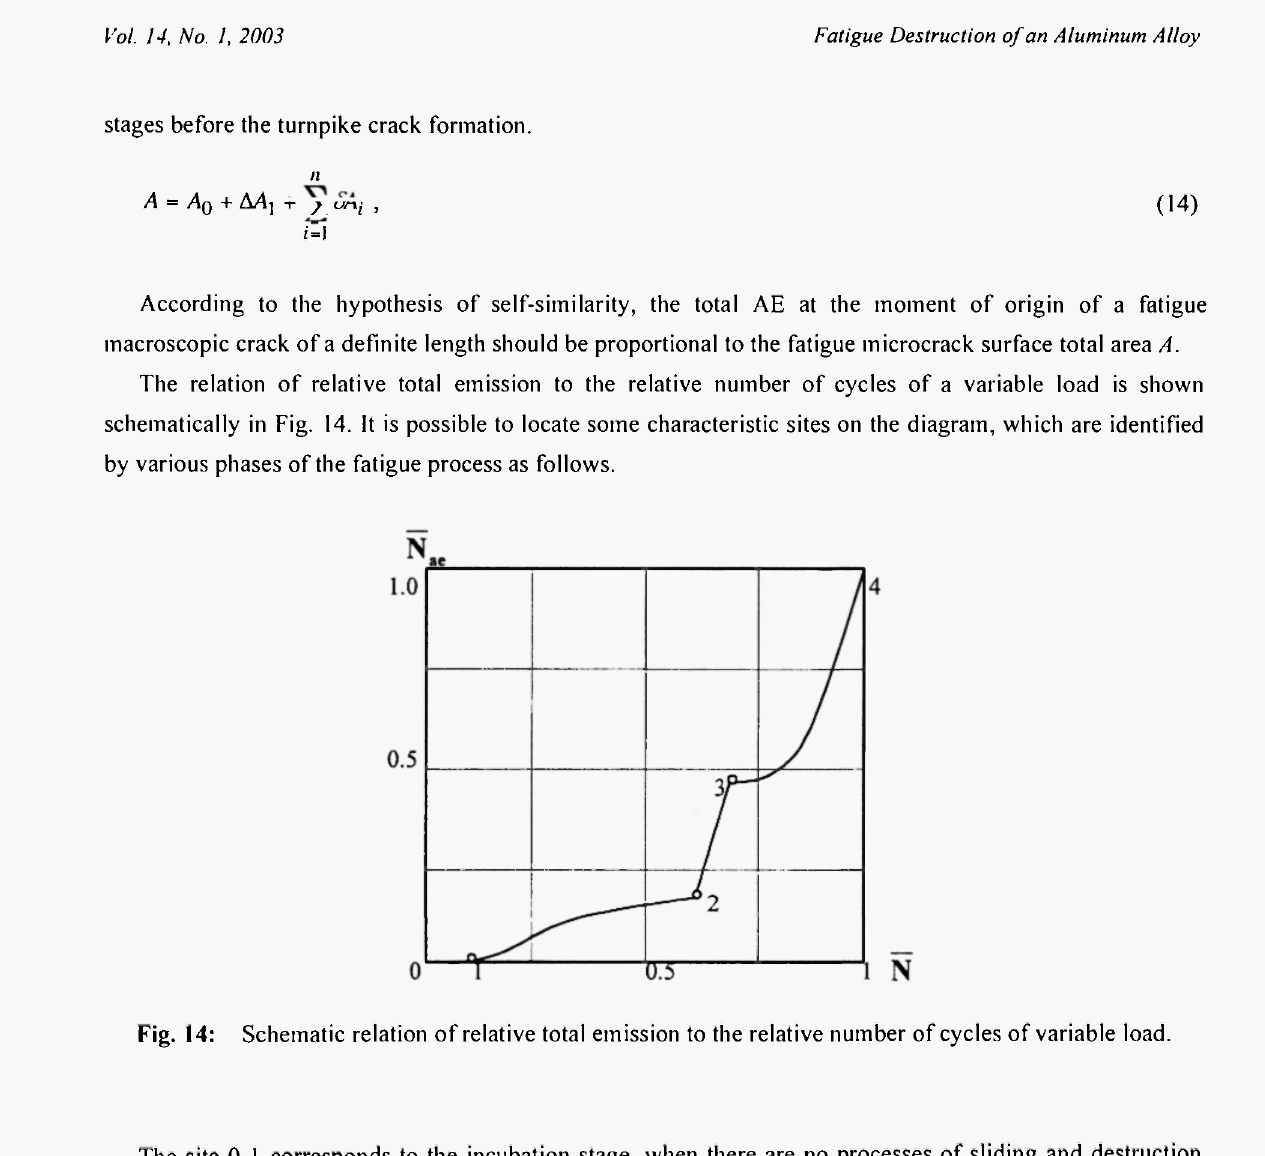
Fig. 14: Schematic relation of relative total emission to the relative number of cycles of variable